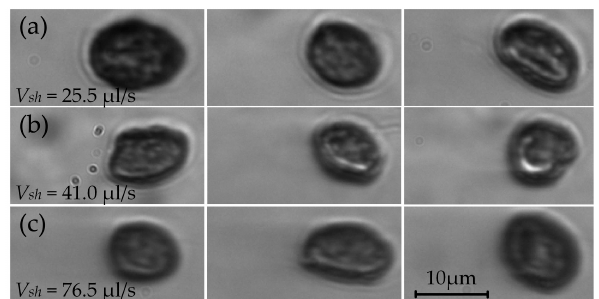
Figure 11. Images of water sample 2 at three different sheath flow rates of ( a ) 25.5 µL/s, ( b ) 41.0 µL/s (i.e., the closest to the optimised sheath flow rate), and ( c ) 76.5 µL/s. The sample flow rate is 1.133 µL/s (i.e., the closest to the optimised sample flow rate). The three photos in each row are taken under the same sample and sheath flow rates.